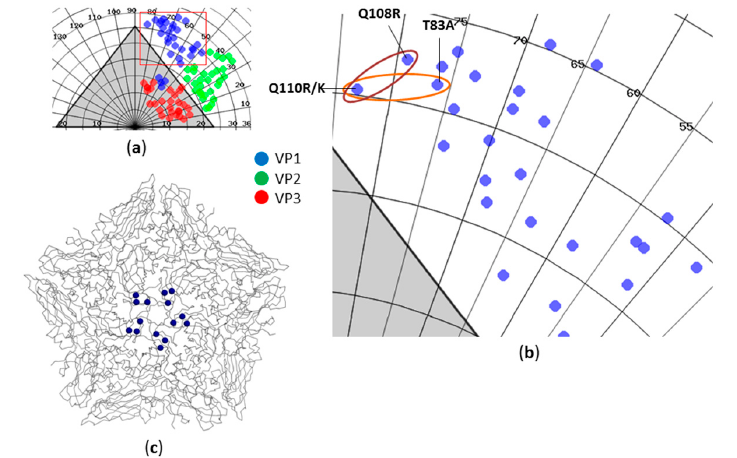
Figure 6. Capsid maps of the outer surface molecules of FMDV. The capsid map was created with VIPER [20] using FMDV O 1 /BFS/1860 and A 10 /Argentina/61 as templates: ( a ) overview of the exposed residues on the outside of the virus capsid, color-coded for VP1 (blue), VP2 (green) and VP3 (red); ( b ) zoom on the location where mutations were found in #3 Asia-1, #8 Asia-1 and #9 Asia-1; ( c ) crystallographic structure of an FMDV capsid pentamer. The VP1 residues 83, 109 and 110 are highlighted. All three mutations are in close spatial proximity to each other and to the fivefold symmetry axis. Residue 110 was mutated in all three viruses, and it appears that this exchange was only possible in combination with a second exchange: either Q108R (in #3 Asia-1 and #8 Asia-1) or T83A (in #9 Asia-1).